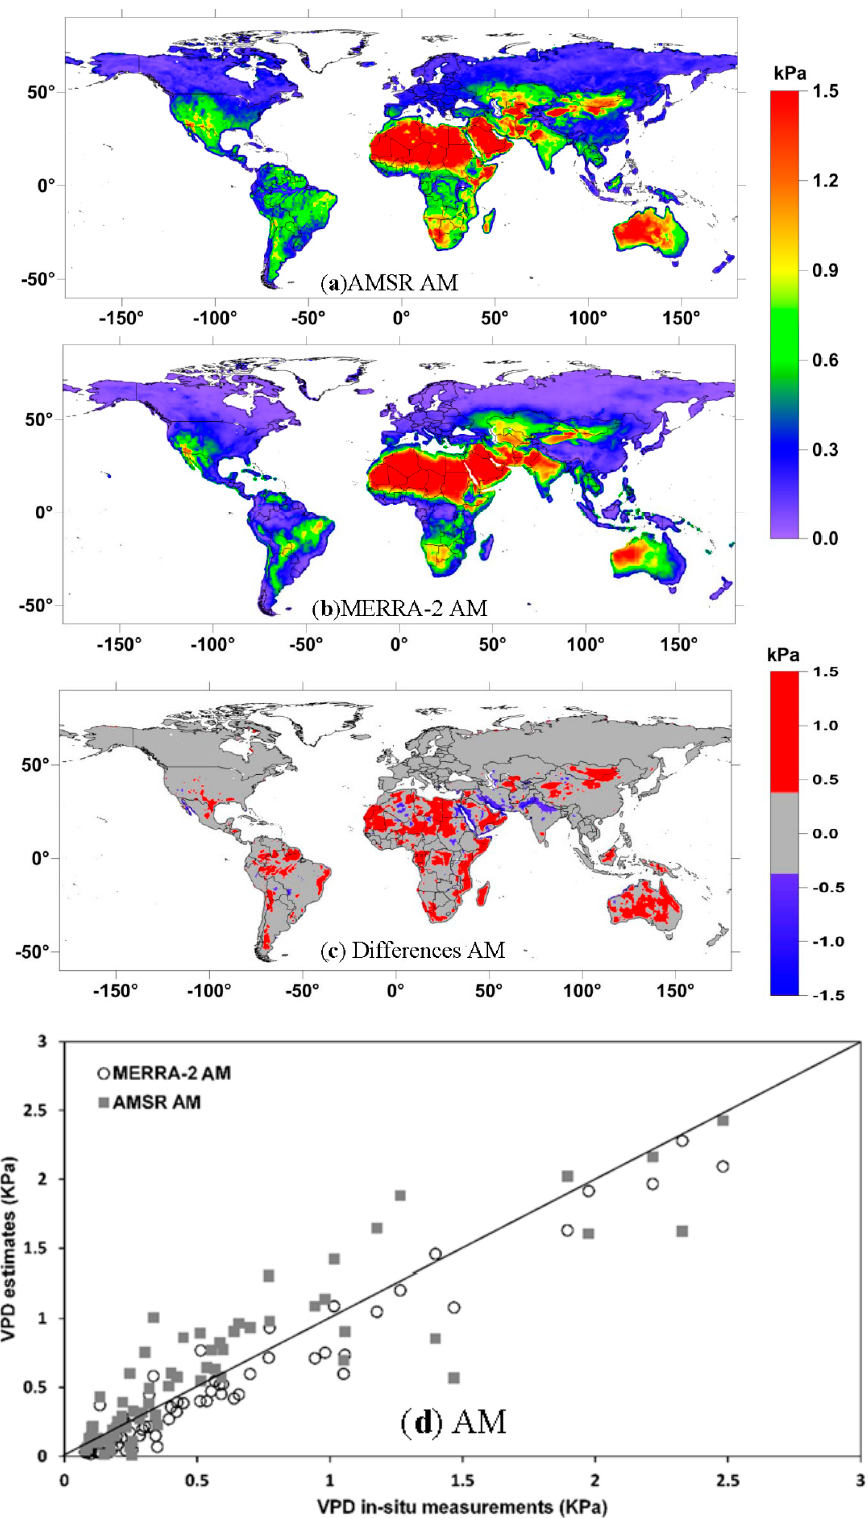
Figure 3. Mean annual Vapor Pressure Deficit (VPD) at ~1:30 a.m. local time derived from ( a ) the Advanced Microwave Scanning Radiometer (AMSR)and ( b ) the Modern-Era Retrospective analysis for Research and Applications, Version 2 (MERRA-2) reanalysis data over 2010; ( c ) the resulting VPD differences (AMSR minus MERRA-2), and ( d ) their comparisons with Integrated Surface Global Hourly (ISH) in-situ measurements.